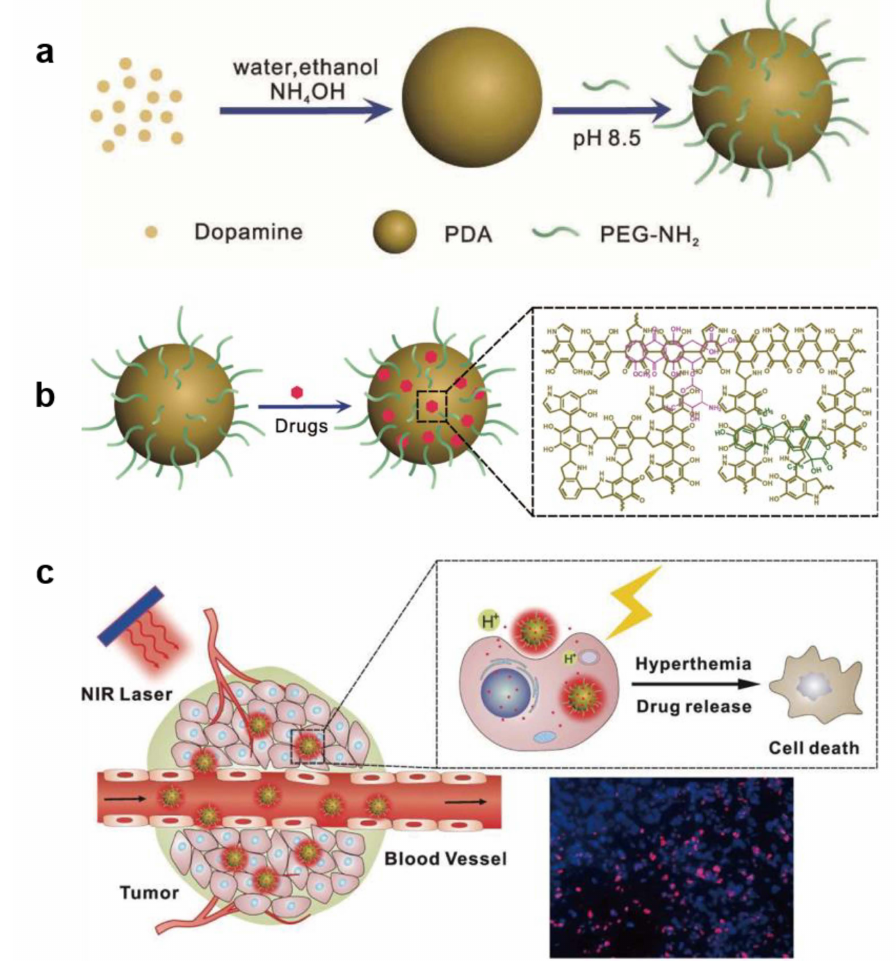
Figure 9. The synthesis ( a ), drug loading behavior of PDA-PEG ( b ) and scheme presentation of PTT-CT synergetic treatment of tumor ( c )